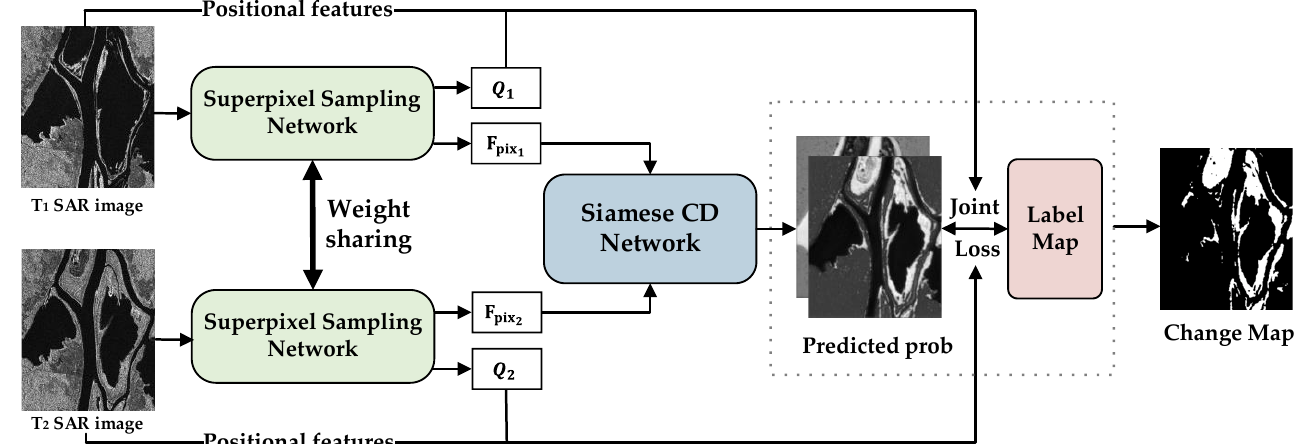
Figure 1. The overall framework of the proposed method. The input of the network is the SAR intensity image pairs and the output is the predicted probability. The joint loss function is used to backpropagate and the binary change map is finally obtained. Training steps see Algorithms 1.